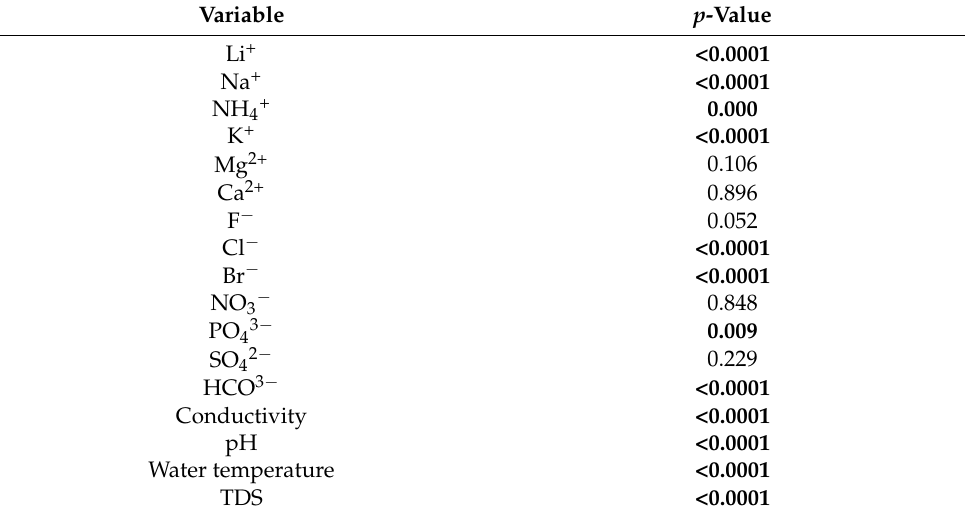
Table 2. Results of the Kruskal–Wallis tests performed on the physical and chemical variables using the two groups created with the PCA. p -values in bold are statistically significant.